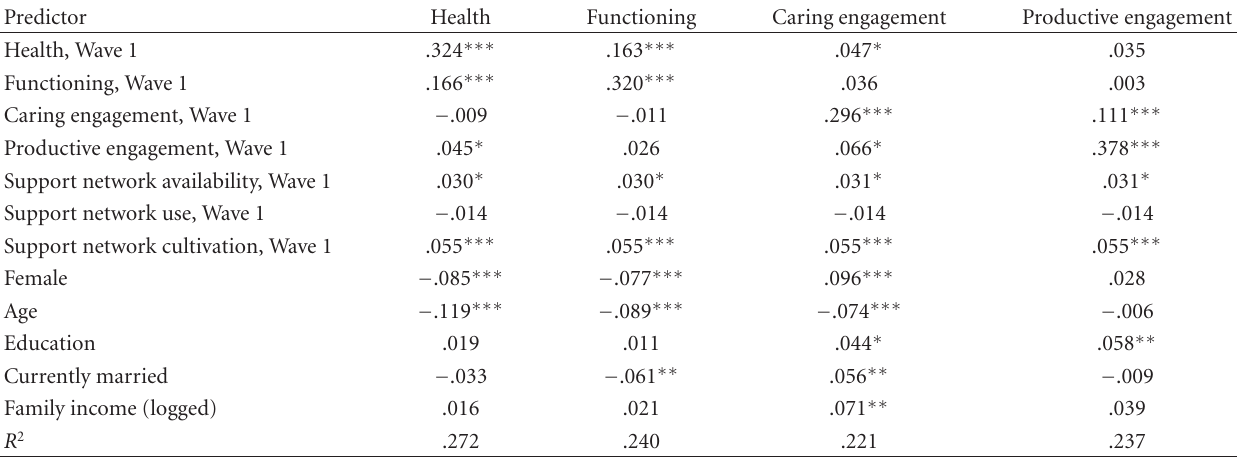
Table 2: Standardized e ff ects on well-being at Wave 2 ( N =